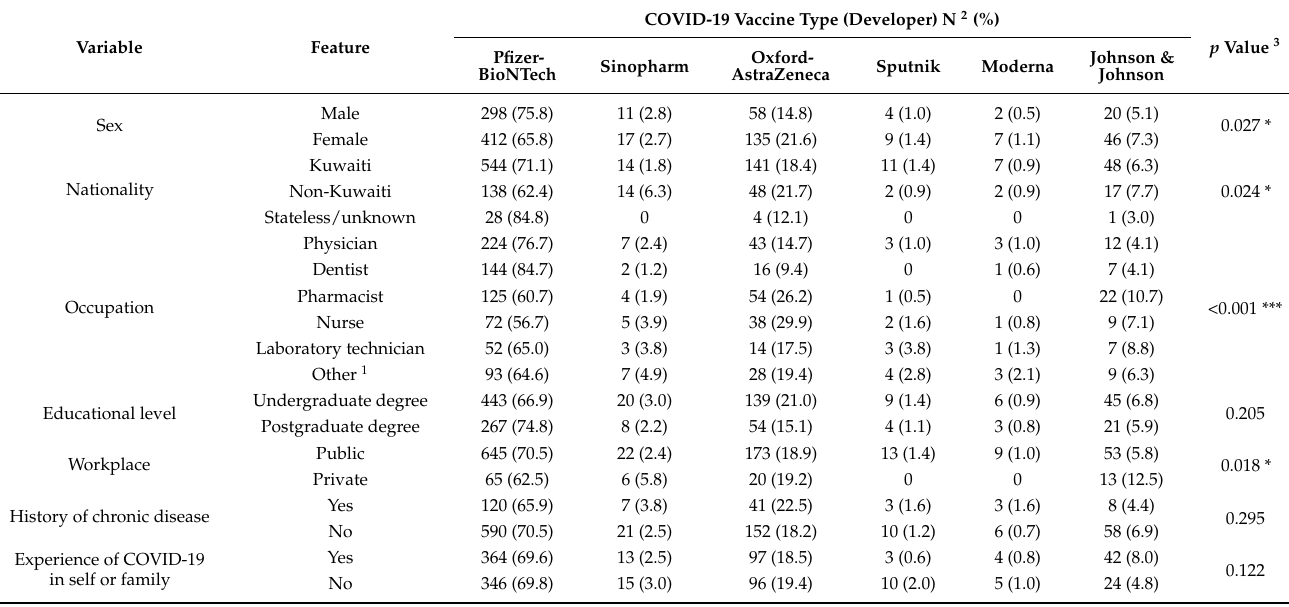
Table 5. Association of vaccine type (developer) preference with participants’